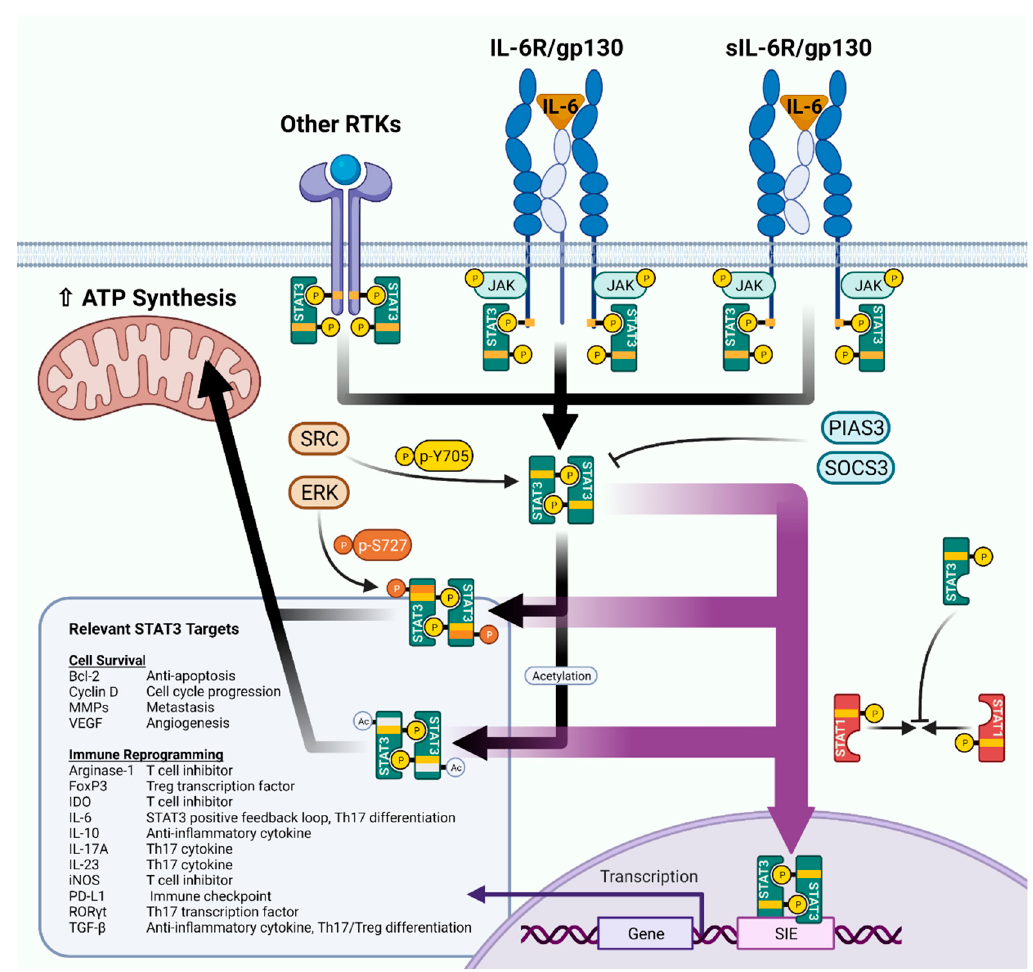
Figure 1. An overview of STAT3 signaling. Figure created in BioRender.